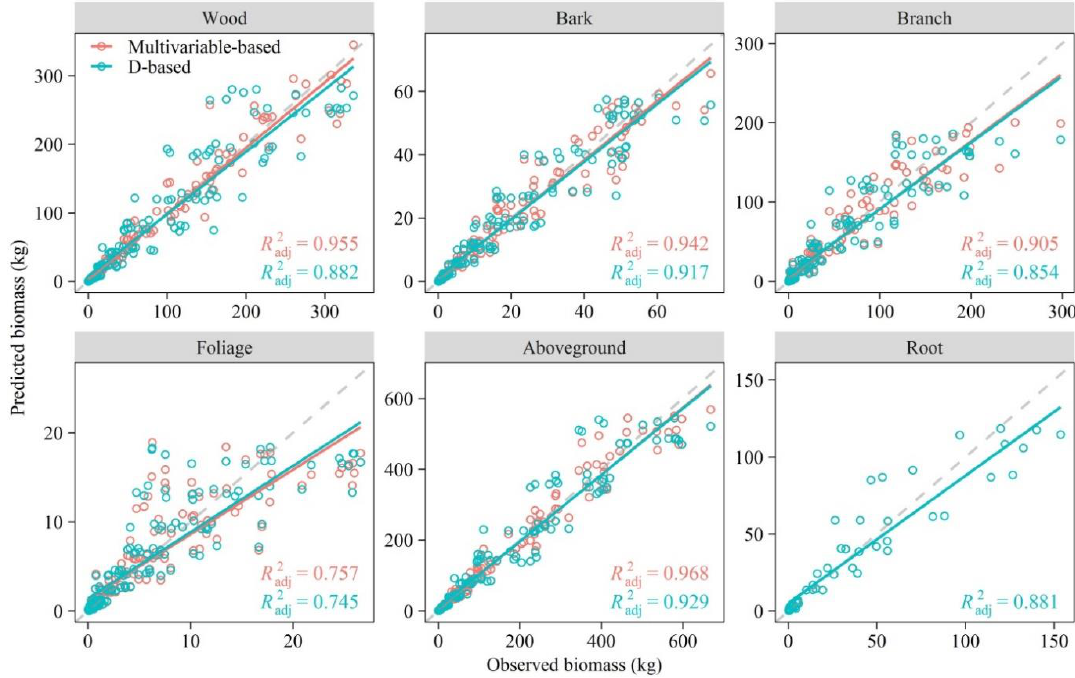
Figure 6. Scatterplots of the predicted ( y -axis) and the observed ( x -axis) values for the wood, bark, branch, leaf, aboveground and root biomass using the leave-one-out cross-validation method.